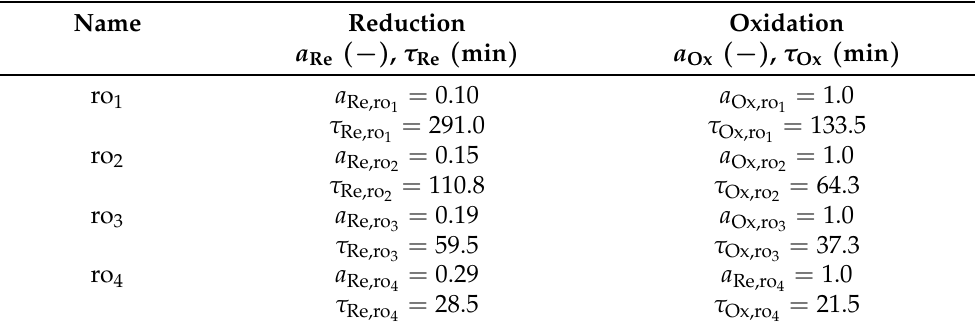
Table 3. Characteristic time constants τ and empirically determined concentration-dependent pa- rameter a for best fitting the experimental data with Equations (8) and (9) for the sample S1 at 700°C, 250mL/min, and the gas concentration ro 1 to ro 4 , as defined in Table 2.